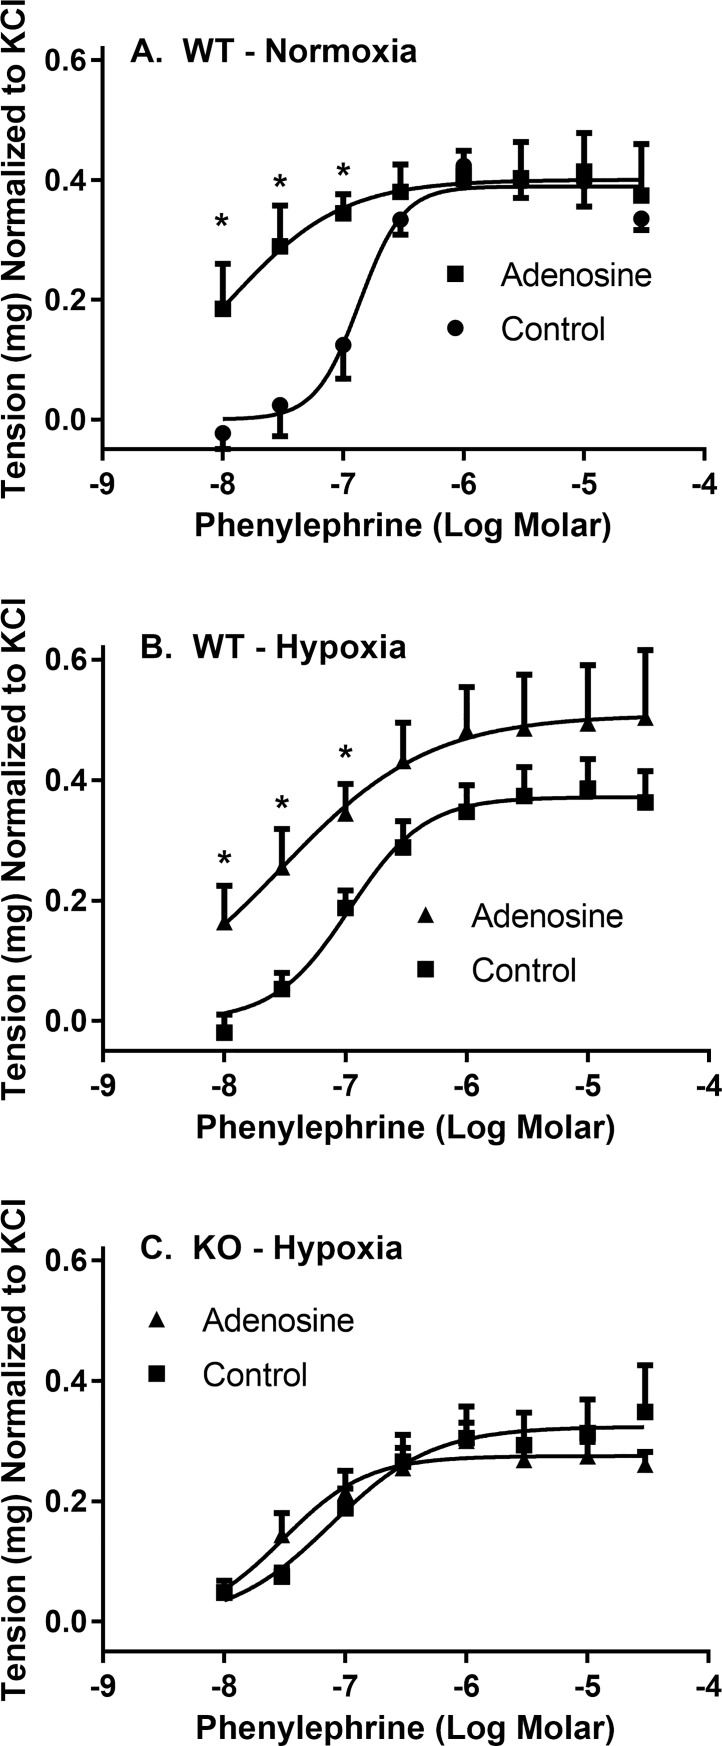
Effect of adenosine pre-incubation on phenylephrine-induced contractions of isolated thoracic aorta from wild-type (WT) and Slc29a1-null (KO) mice.Tissues were incubated for 30 min at 37°C in KPSS buffer at resting tensions of 500 mg after which they were depolarized with 100 mM KCl. Tissues were then incubated in the presence or absence of 10 μM adenosine for 30 min, and then washed and incubated for an additional 60 min under either normoxic (Panel A) or hypoxic (Panels B and C) conditions. Each point is the mean ± SEM from 6 experiments. *Significant difference between treatment groups (Student’s t-test for unpaired samples, *P<0.05).